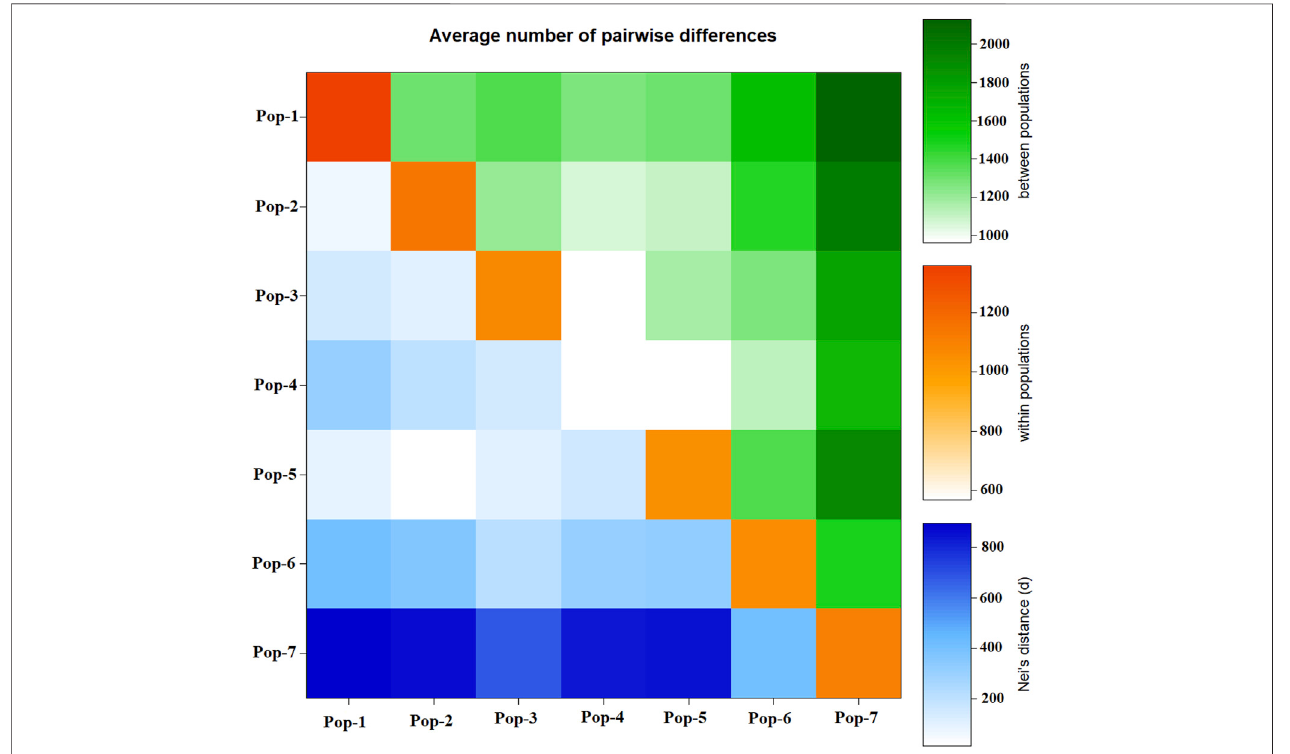
FIGURE 5 | Graphical representation of the average number of pairwise differences between the seven fi nger millet populations generated using 5,226 SNP markers. Below diagonal represents Nei ’ s genetic distance, diagonal represents pairwise differences within populations, and above diagonal represents pairwise differences between